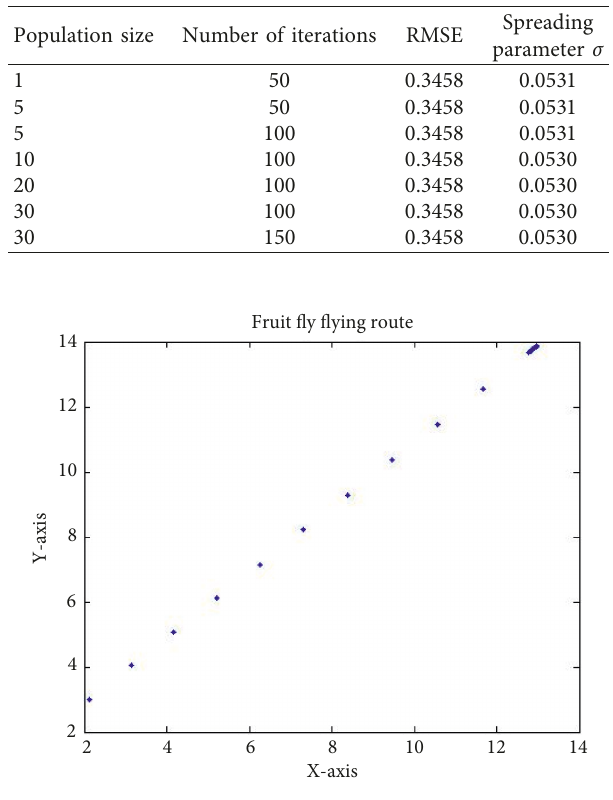
Table 4: Optimal spreading parameters under different parameters.